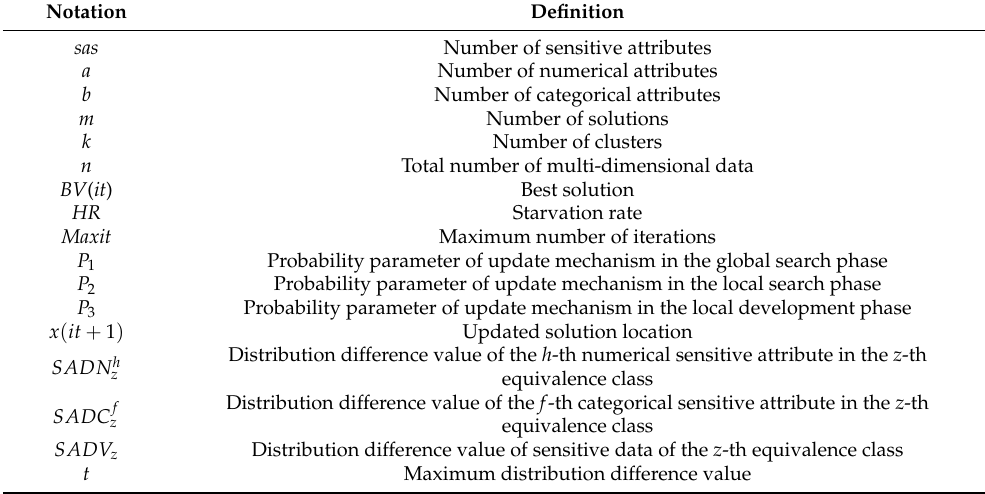
Table 5. Notations and definitions.